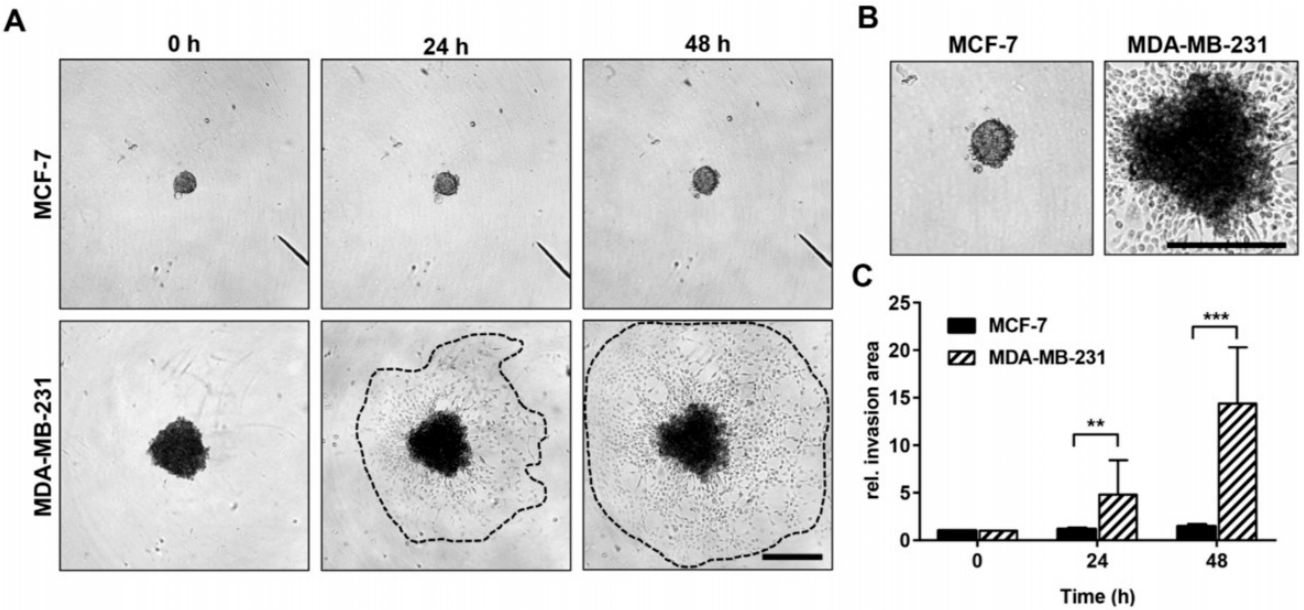
Figure 3. Invasive growth rate of MCF-7 and MDA-MB-231 breast cancer cells in vitro. ( A ) Representative light microscopy images of MCF-7 and MDA-MB-231 spheroids and their surrounding invasion area 0 h, 24 h, and 48 h after embedment into an artificial Matrigel ECM. Dotted lines mark the boundaries of the invasion area of MDA-MB-231 cells. Scale bar: 500 µm (applies to both cell lines and all images). ( B ) Digitally enlarged images of MCF-7 and MDA-MB-231 spheroids already shown in ( A ) after 48 h of incubation. Scale bar: 500 µm (applies to both cell lines and all images). ( C ) Time-dependent invasive growth rate of MCF-7 ( n = 16) and MDA-MB-231 ( n = 16) cells (defined as relative invasion area) as determined by dividing the measured invasion area (24 h and 48 h) by the initial spheroid size (area occupied by spheroids at 0 h). Mann ‒ Whitney test: values represent means ± standard deviations (SD). ** indicates p < 0.01; *** indicates p < 0.001.